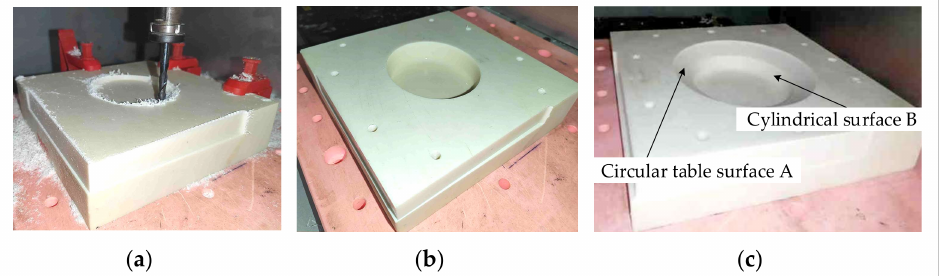
Figure 25. The actual support: ( a ) milling process; ( b ) for the traditional multistage forming, ( c ) for the proposed method.